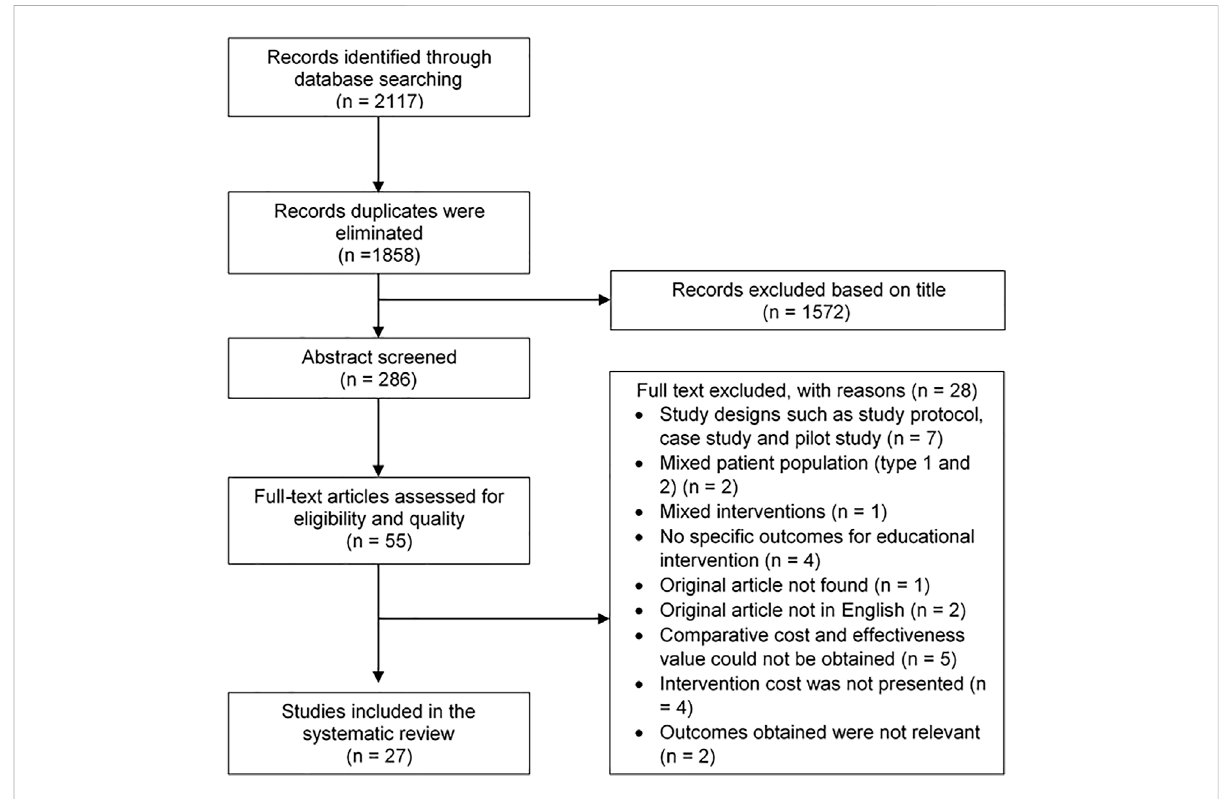
FIGURE 1 Flow diagram for selection of articles of a systematic review of the cost-effectiveness of different types of educational interventions in type II diabetes mellitus.